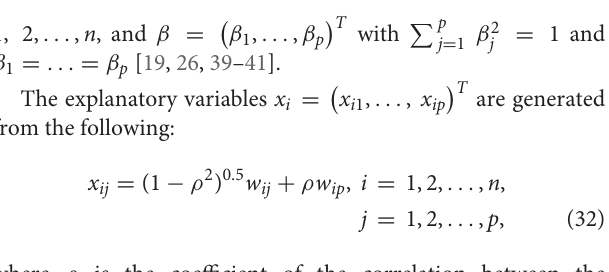
TABLE 3 | Mean squared error values for different estimators when n